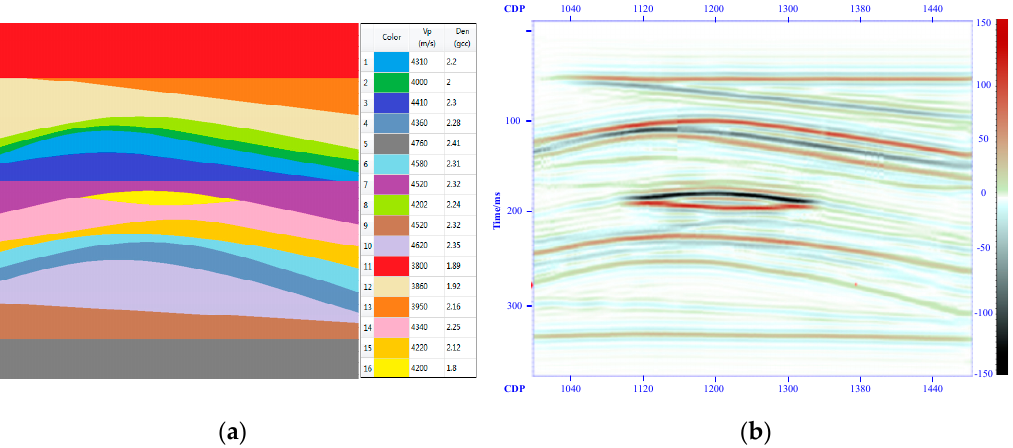
Figure 5. ( a ) Complicated geological model; and ( b ) synthetic seismic section.